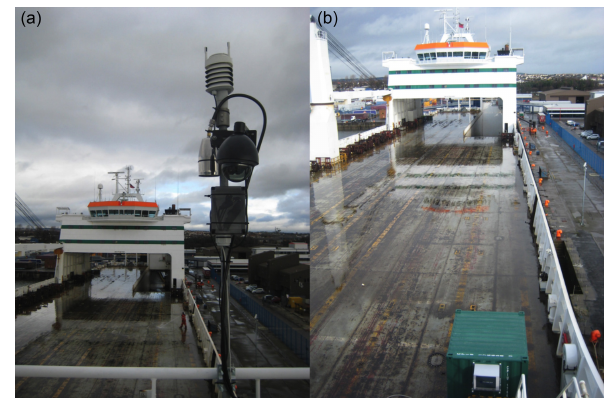
Figure 4. Photos of the North Sea ferry mobile GHG laboratory on the DFDS Seaways Longstone (now the Finnmerchant ). View of the (a) weather station mounted on the top deck and (b) from the air inlet mounted on top of the mobile laboratory located on the weather deck. Figure 5. Observed temporal and spatial variations in CH